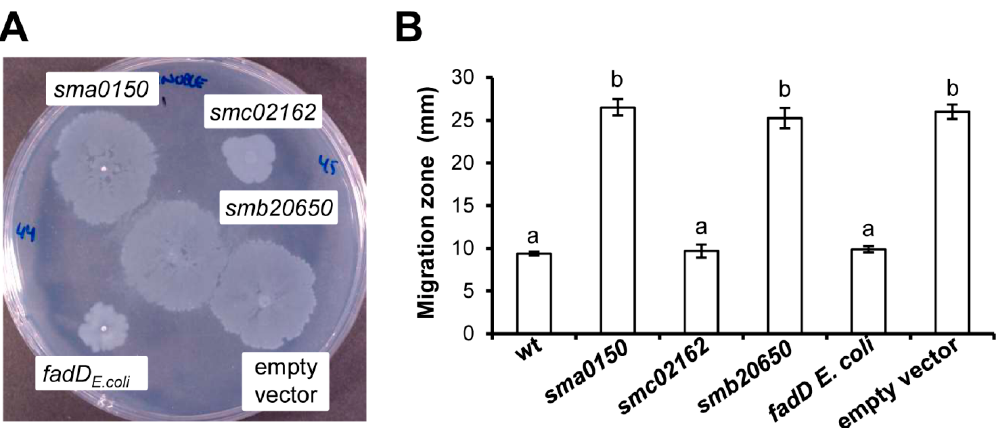
Figure 4. Effect of different fadD homologues on the surface motility of S. meliloti QS77 ( smc02162 - ). ( A ) A representative picture of surface motility on Robertsen semisolid MM (0.6% Noble agar) shown by QS77 harbouring either pRCanul1 ( sma0150 ), pRCanul2 ( smc02162 ), pRCanul3 ( smb20650 ), pNG28 (empty vector), or pRCanul 4 ( fadD Ecoli ). ( B ) The surface expansion shown by the wild type strain and QS77 derivatives shown in ( A ). The bars and error bars represent the mean and standard error of the migration zones obtained for each strain from two independent biological experiments with at least four technical replicates. Different letters indicate significant differences according to an analysis-of- variance test ( p ≤ 0.05).